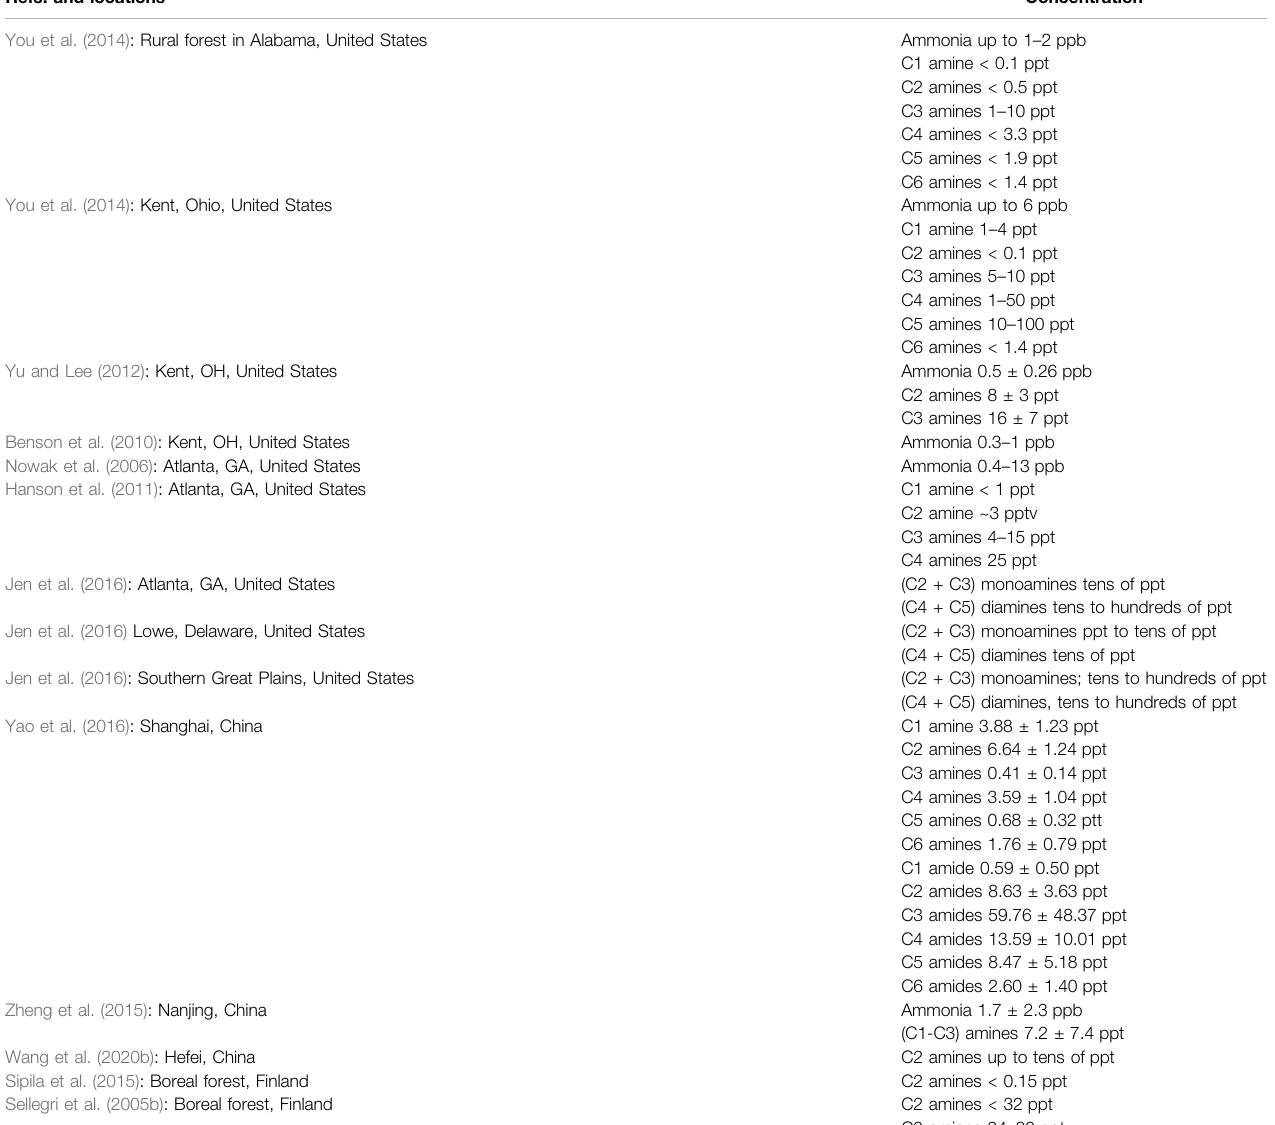
TABLE 1 | RNC concentrations measured with CIMS and CI-APi-TOF. Refs. and